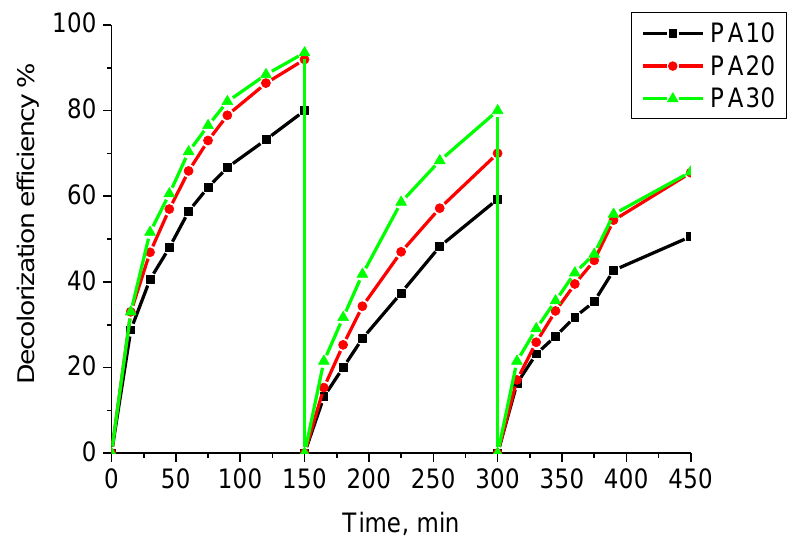
Figure 8. Reuse of PA10, PA20, and PA30 composite materials obtained with UV Light.